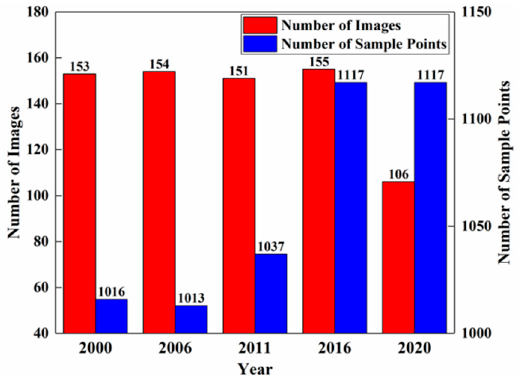
Figure 3. The number of covered images and sample points in the study area.